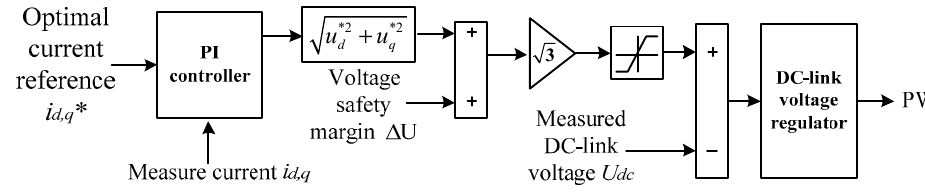
Figure 6. The details of the dynamic DC-link voltage controller.